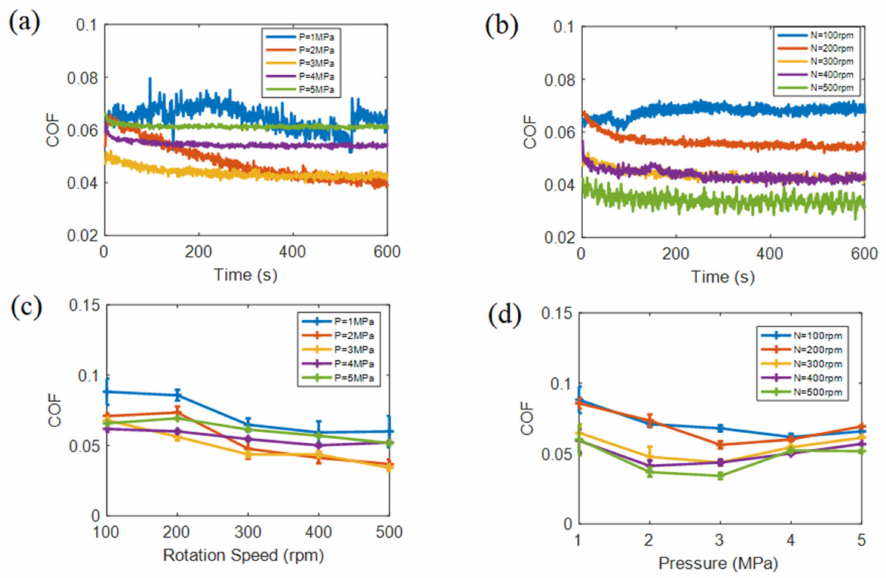
Figure 4. The COF under water lubrication, ( a ) COF vs. time with different loads under the middle speed of 300 rpm, ( b ) COF vs. time with different speeds under middle load of 3MPa, ( c ) average underwater COF vs. speed and ( d ) average underwater COF vs.